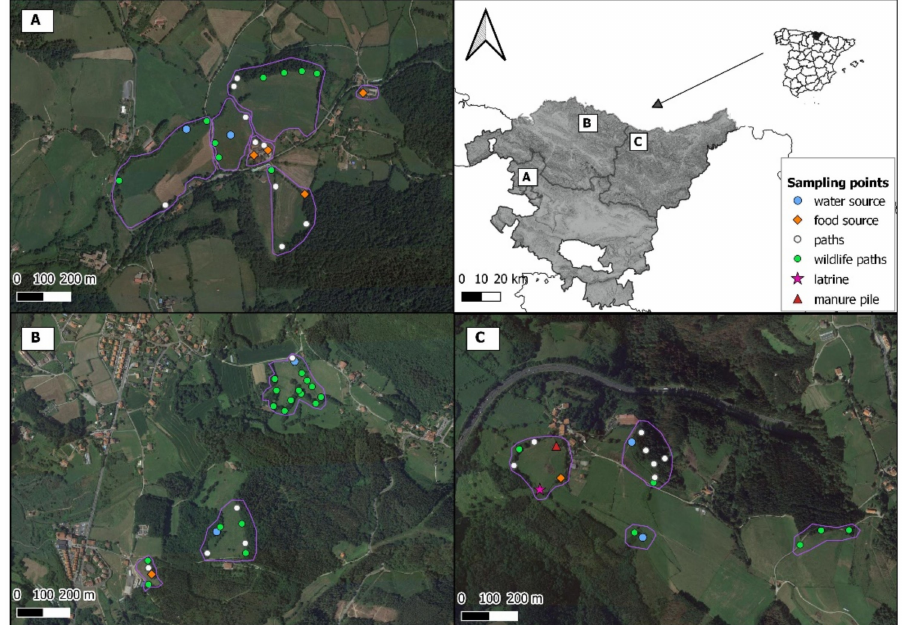
Figure 1. Field sampling design. The map shows the location of the studied farms ( A – C ) within the Basque Country (northern Iberian Peninsula). The spatial distribution of the sampling points recorded within farms ( A – C ) is displayed on the satellite photographs ( A – C ), respectively (see legend for sampling point description). Purple lines surround the sites (1 to 13) included in the models as a random